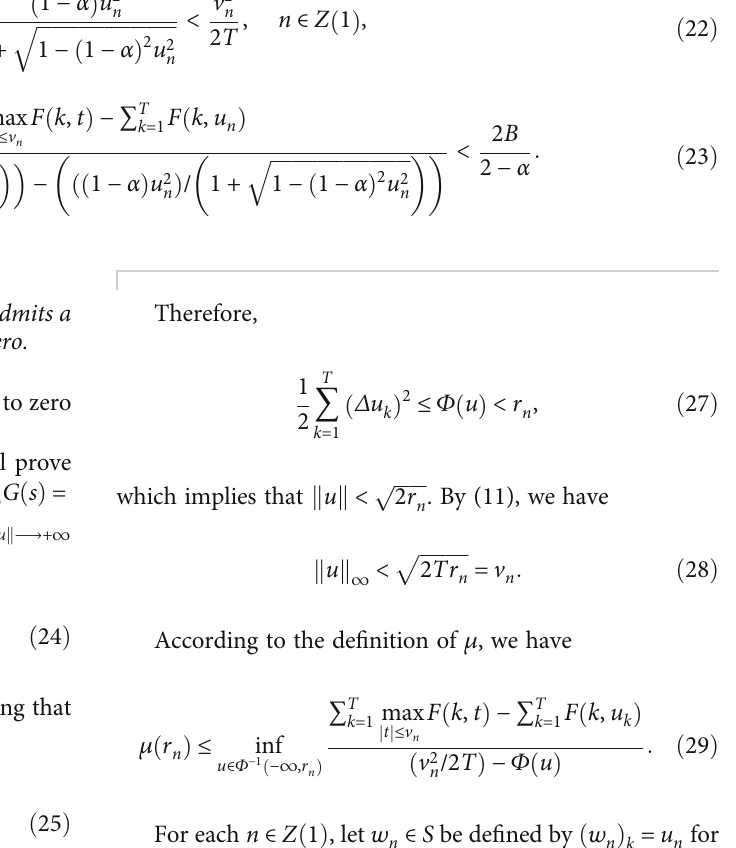
ffiffiffiffiffiffiffiffiffiffiffiffi − 1 − u 2 n